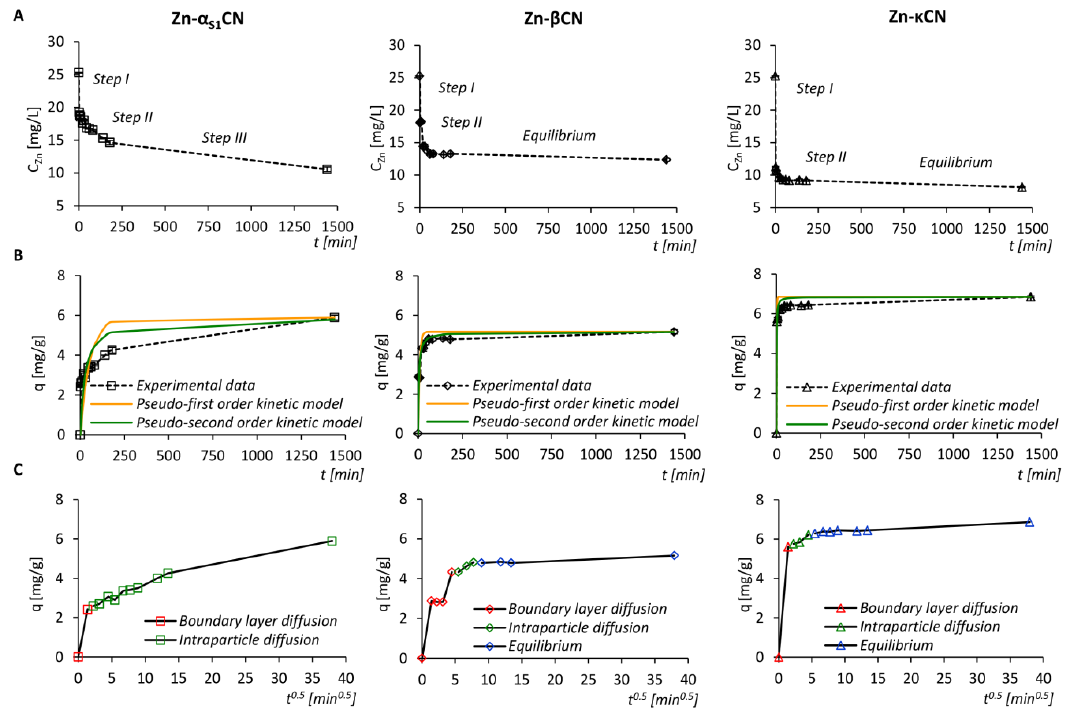
Figure 2. The kinetic steps of the Zn 2+ sorption onto α S1 CN, βCN and κCN using the zero-order kinetic model ( A ), experimental data and fitted pseudo-first- and pseudo-second-order kinetics models of the Zn 2+ sorption by isoforms of casein ( B ) and the Weber–Morris intraparticle diffusion model ( C ).